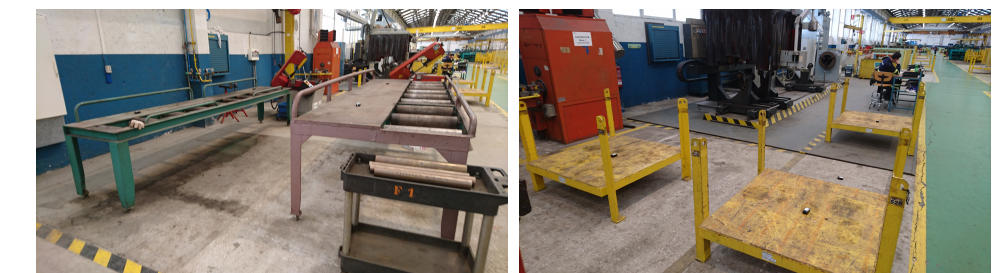
Figure 7. Saws of the Cutting Area.